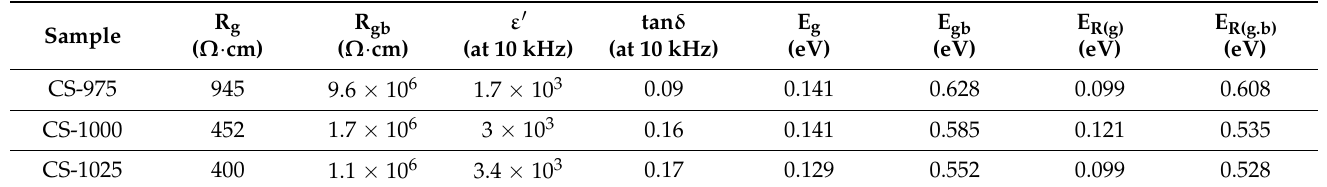
Table 2. Room temperature resistivity (R), dielectric constant ( ε (cid:48) ), dielectric loss (tan δ ), and the value of activation energy (E) for conduction in the grain and grain boundary of CS-975, CS-1000, and CS-1025 LCTO ceramics. Sample